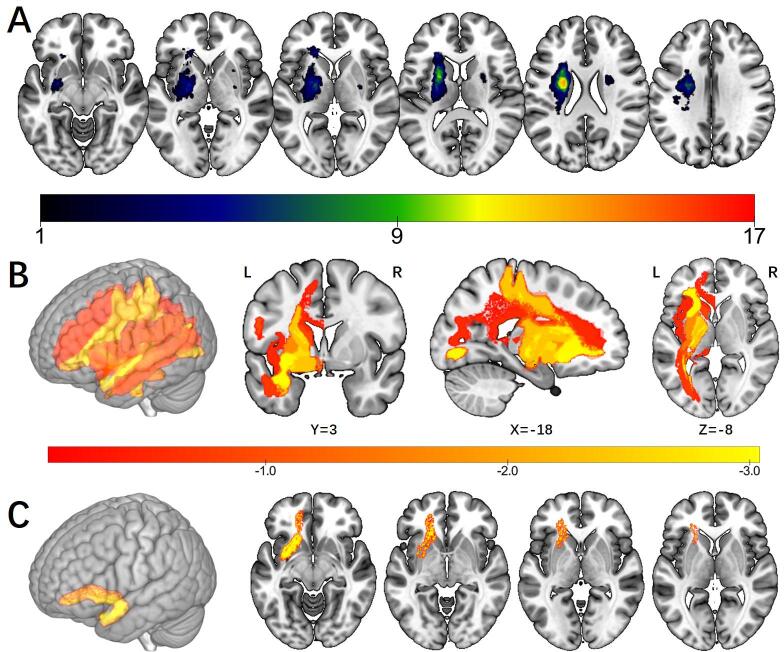
Overlap of lesions and results of region-wise lesion-symptom mapping analysis. A. Overlap of lesions in 36 baseline PSSA patients. The color indicates the number of participants having a lesion at a given location. B. Statistical maps of RLSM analysis. Nineteen regions were included in the RLSM analysis. The color indicates the z score of each region. C. Results of RLSM analysis. Only the left UF survived in the permutation test (Z = −3.04, permutation-corrected P < 0.05). Abbreviation: RLSM: region-wise lesion-symptom mapping; UF: uncinate fasciculus.